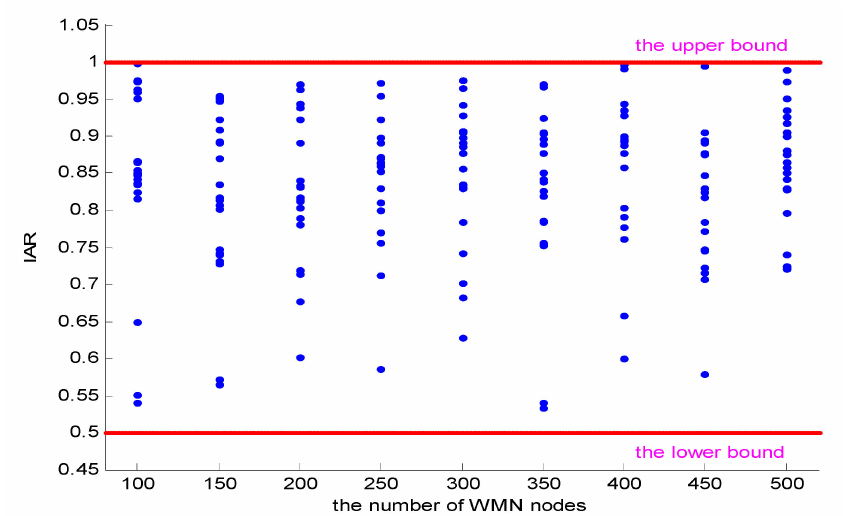
Figure 6. Analysis of the approximation